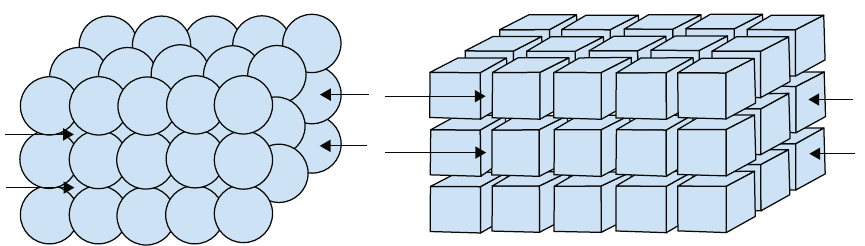
Figure 3: Unsteady state (a) and pseudosteady state (b) sorption/di ff usion.